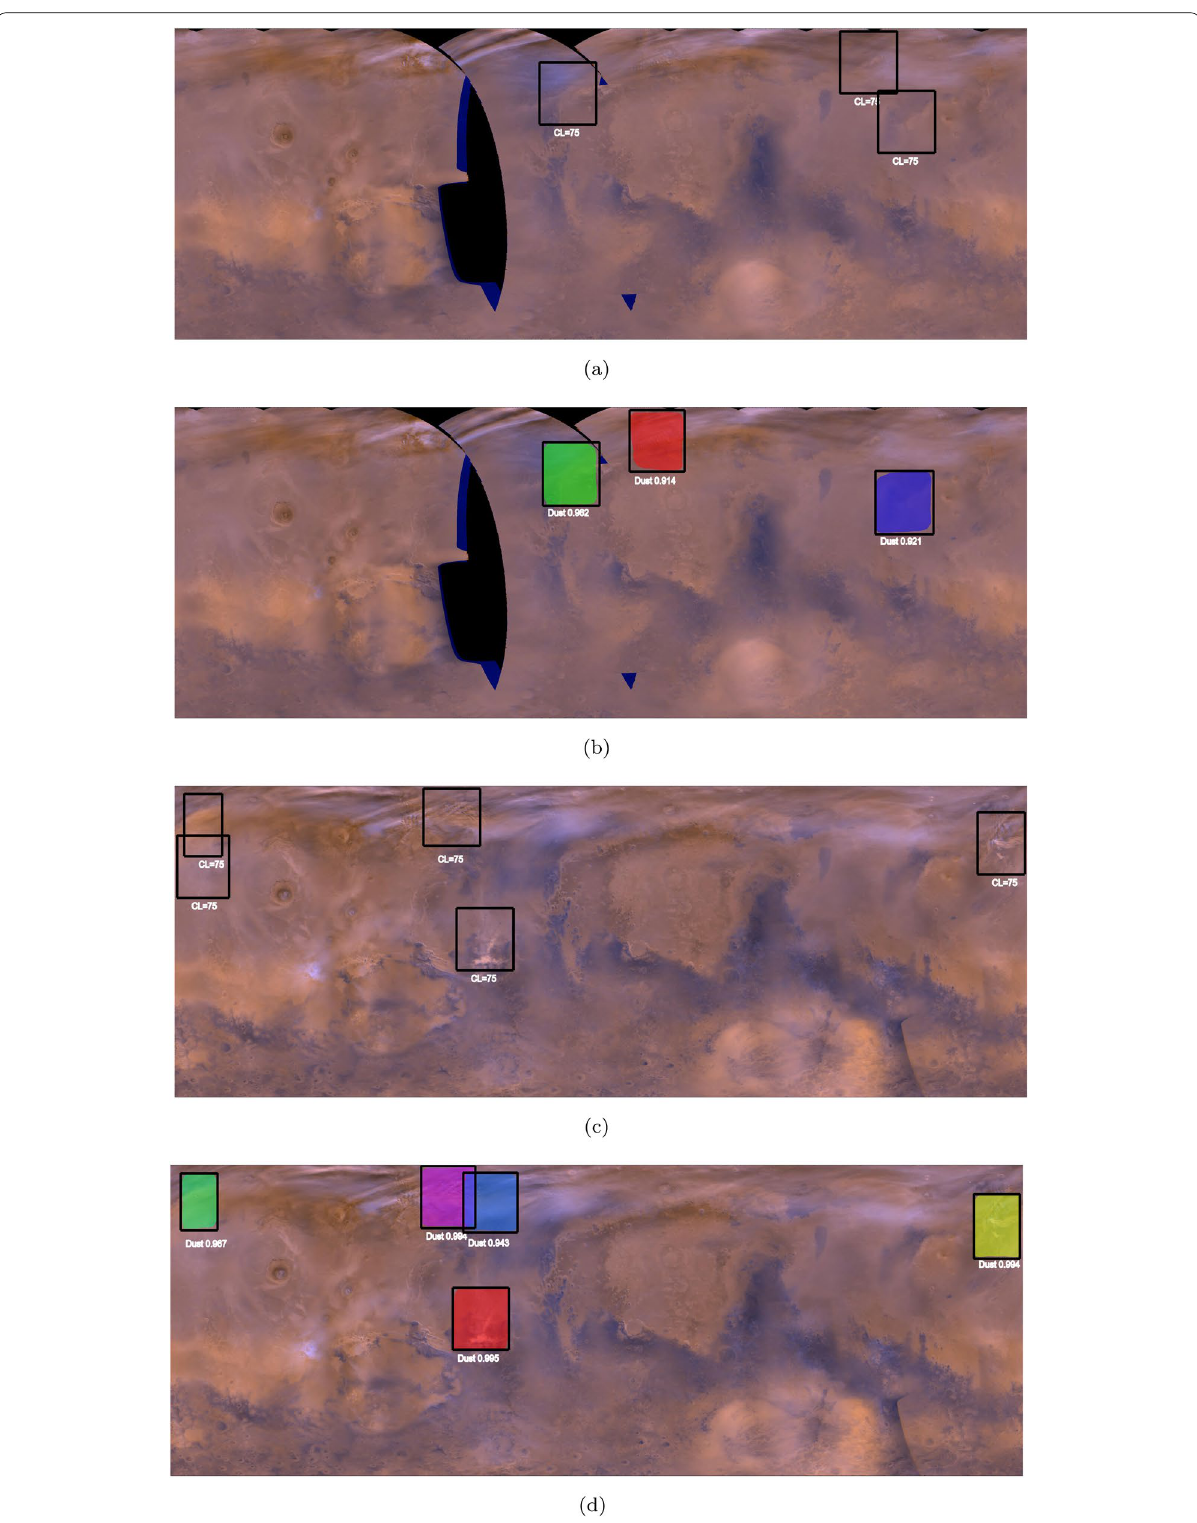
Fig. 6 2nd strategy: the training, validation and testing images are selected randomly from MY 25 to MY 28. Left panel shows ground-truth maps, and right panel shows predicted maps. a and c are ground-truth images from fall season ( r 08_005 ) at L S = 238.51 ◦ and winter season ( r 12_017 ) at L S = 313.57 ◦ and b and d are their predicted dust